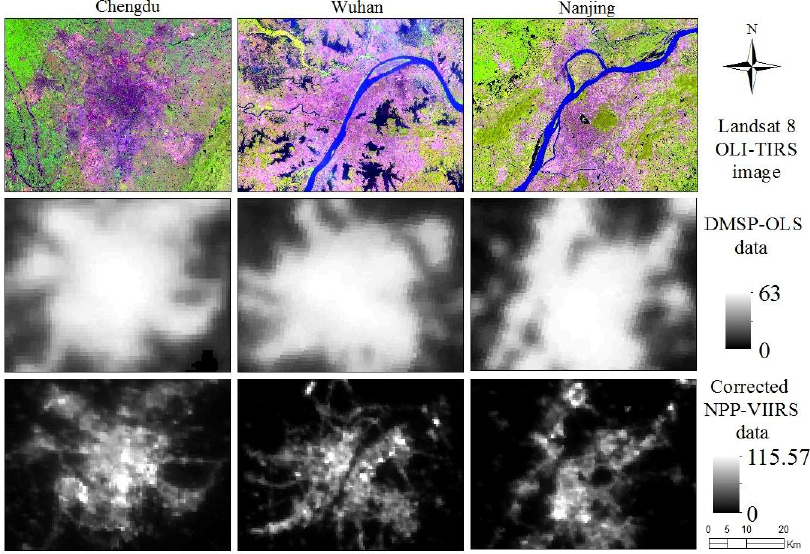
Figure 7. Comparison among the DMSP-OLS data, corrected NPP-VIIRS data, and Landsat 8 OLI-TIRS images for three cities in